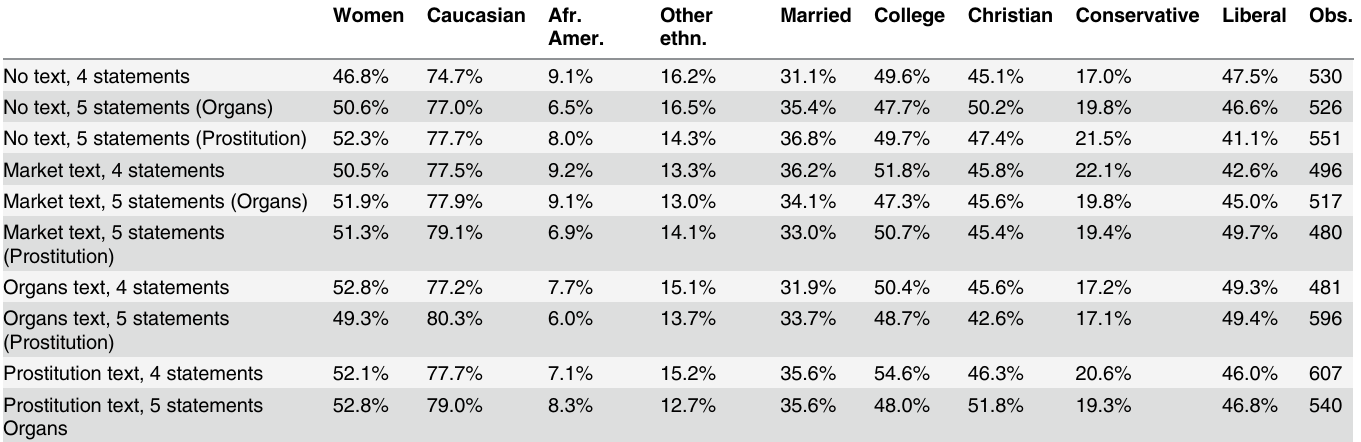
Table 2. Descriptive statistics on individual characteristics collected from the survey, overall and by experimental condition. Women Caucasian Afr. Other Amer.